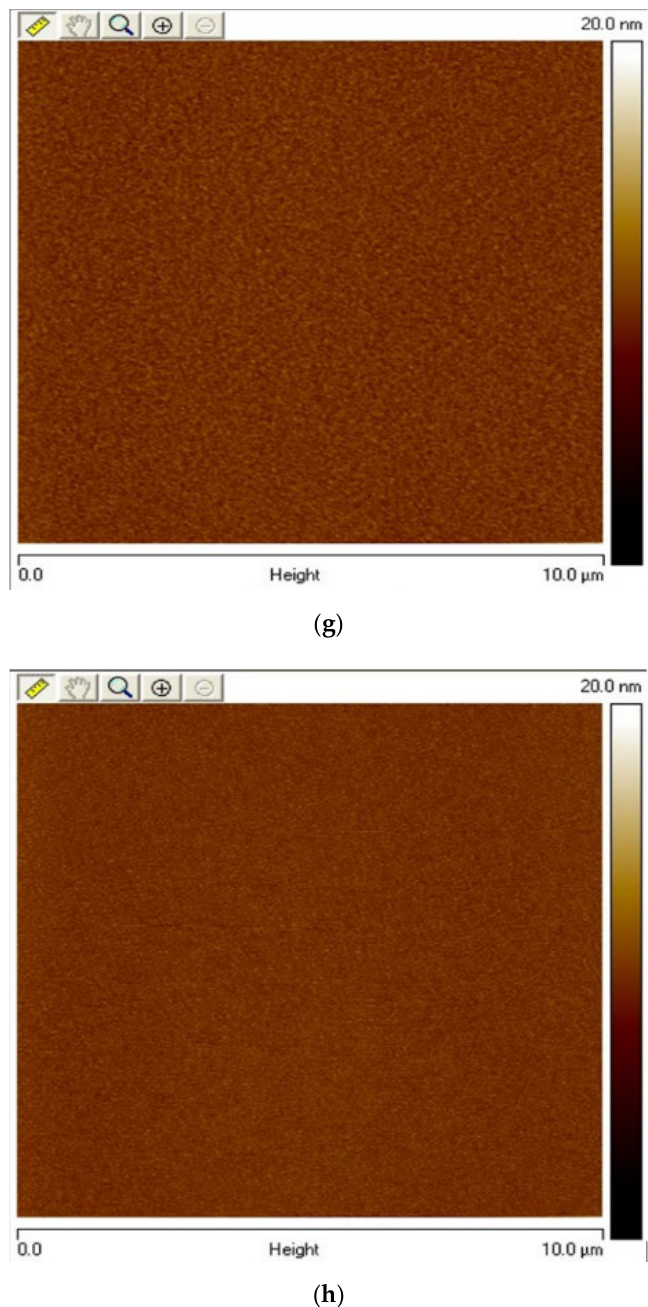
Figure 4. 2D-AFM of WO 3 film ( a ) as-dep RMS: 0.156 nm, ( b ) RTA 400 °C RMS: 0.354 nm, ( c ) RTA 500 °C RMS: 0.409 nm, and ( d ) RTA 600 °C RMS: 0.314 nm in O 2 ambient for 30 s. 2D-AFM of Y- 500 ◦ C RMS: 0.409 nm, and ( d ) RTA 600 ◦ C RMS: 0.314 nm in O 2 ambient for 30 s. 2D-AFM of Y-doped doped WO 3 film ( e ) as-dep RMS: 0.29 nm, ( f ) RTA 400 °C RMS: 0.594 nm, ( g ) RTA 500 °C RMS: 0.474 WO 3 film ( e ) as-dep RMS: 0.29 nm, ( f ) RTA 400 ◦ C RMS: 0.594 nm, ( g ) RTA 500 ◦ C RMS: 0.474 nm, nm, and ( h ) RTA 600 °C RMS: 0.464 nm in O 2 ambient for 30 s. and ( h ) RTA 600 ◦ C RMS: 0.464 nm in O 2 ambient for 30